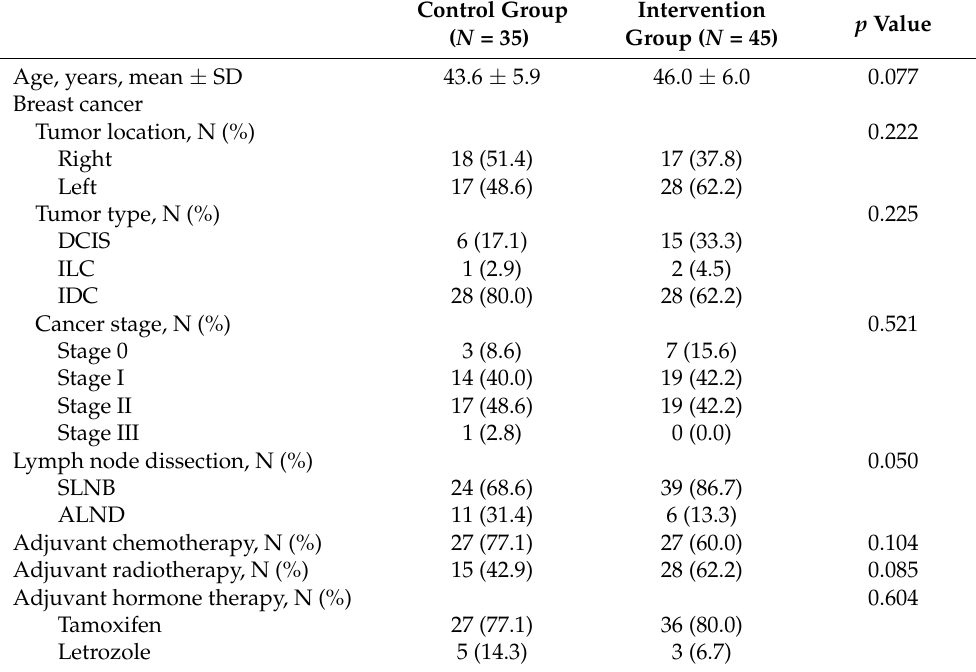
Table 1. Clinical characteristics of participants.